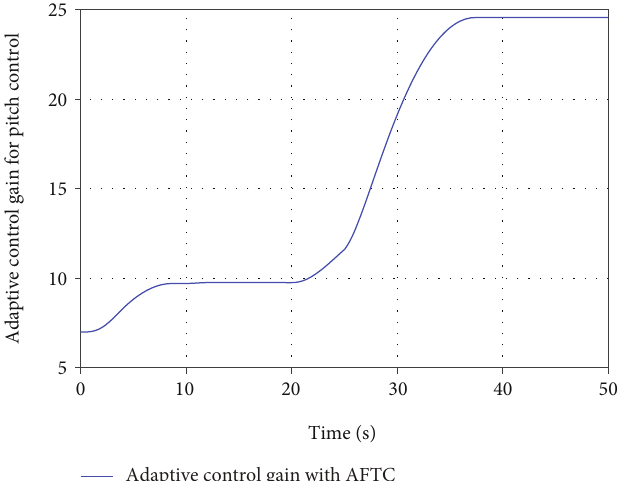
Figure 10: Change of adaptive control parameter in the presence of concurrent elevator and canard control surface faults in scenario